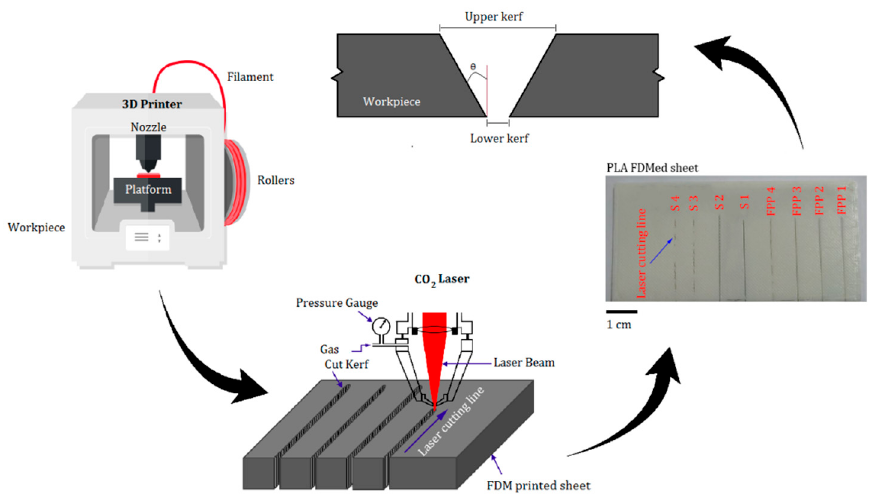
Figure 2. A schematic of the experimental process.